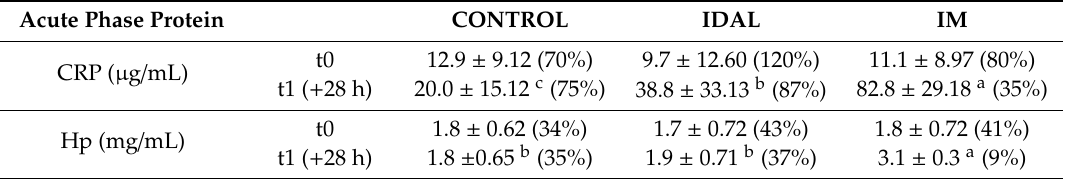
Table 5. Means, SD and coe ffi cient of variation (CV) of blood acute phase proteins CRP and Hp for the CONTROL, IDAL and IM treatments on day 0 (baseline) and day + 1 (28 h) after the vaccination. Acute Phase Protein